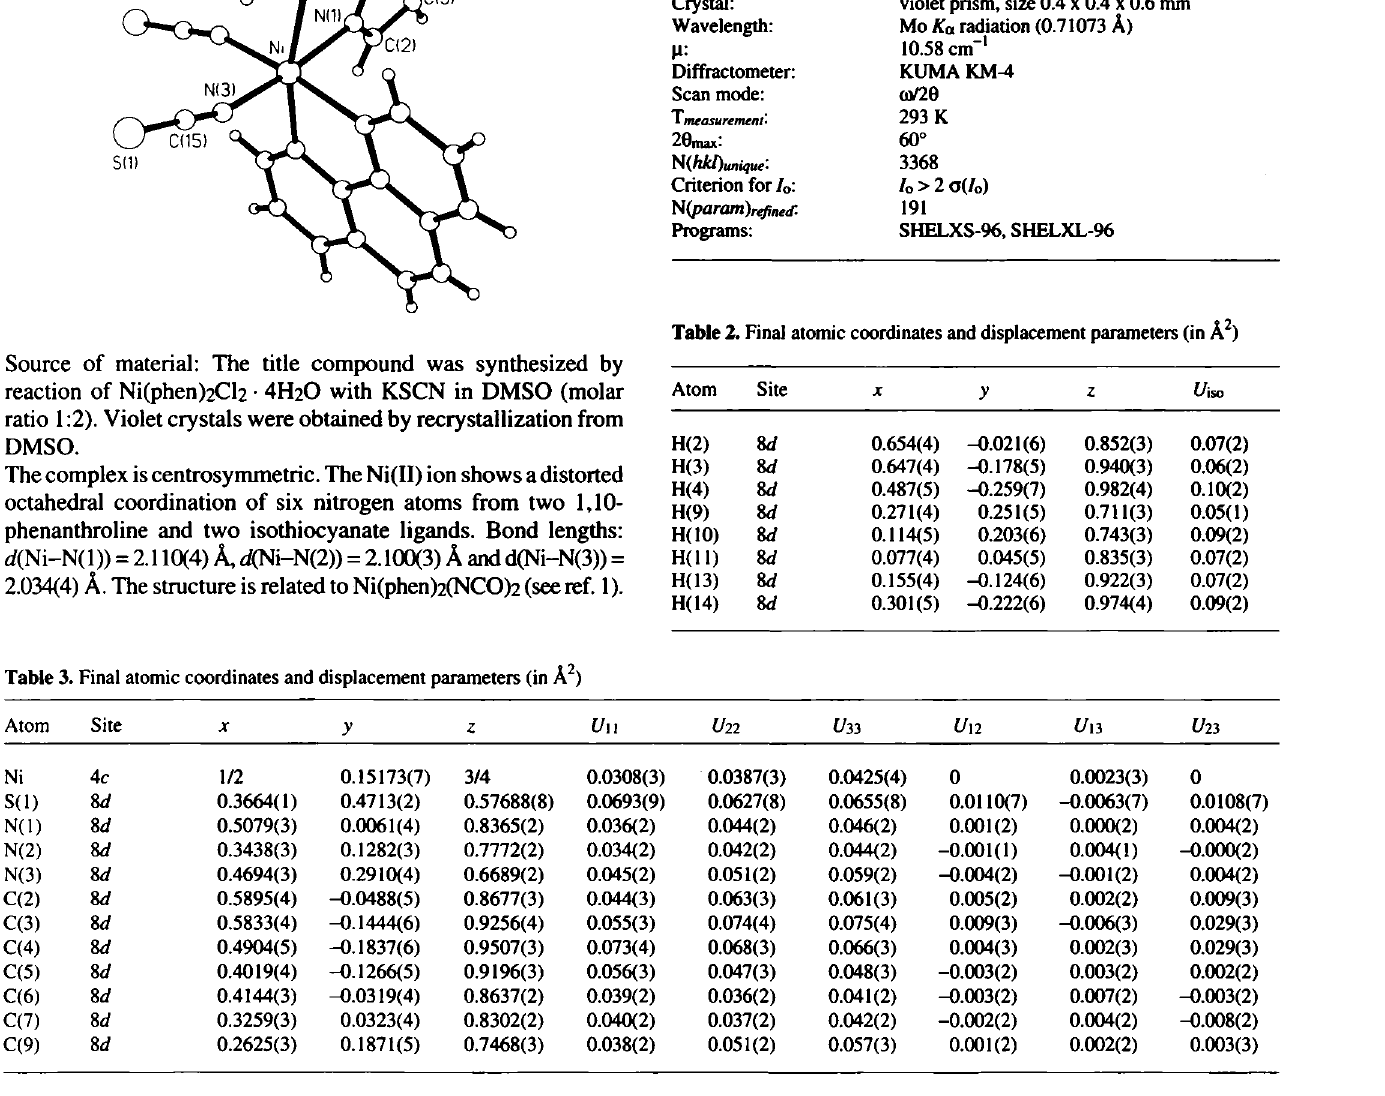
Table 1. Parameters used for the X-ray data collection Crystal: